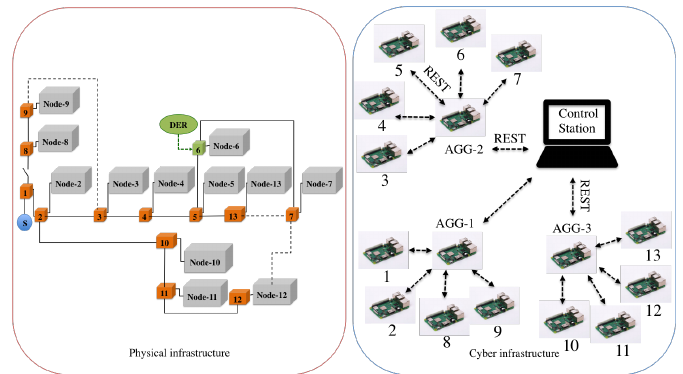
Figure 5. The implementation overview with respect to physical 13-node distribution system and cyber system.